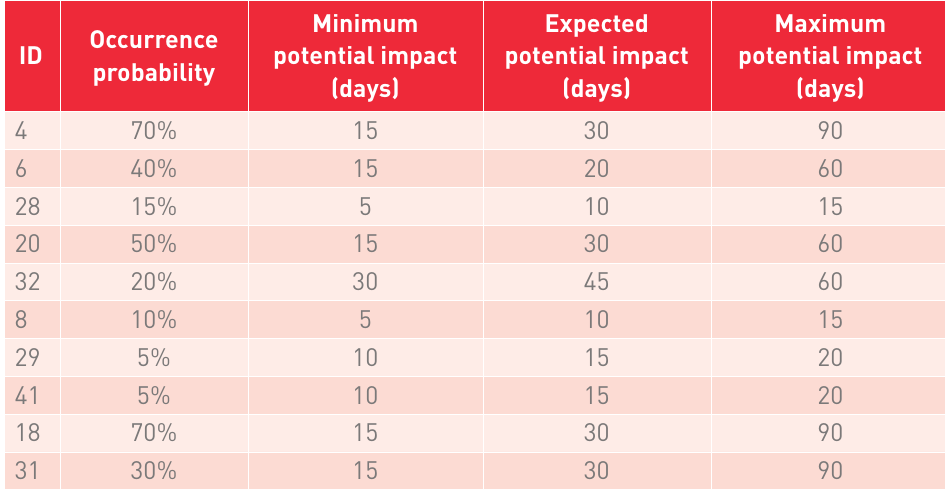
Risks, occurrence probability and triangular distribution parameters of the potential